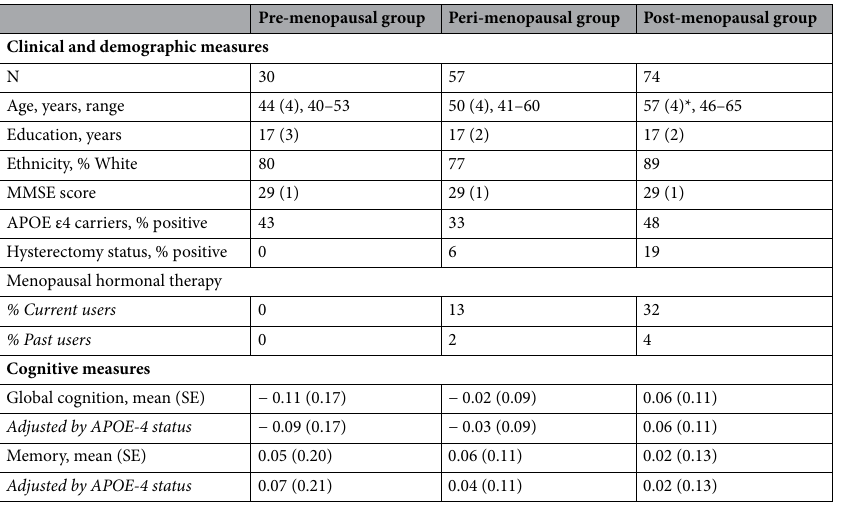
Table 1. Participants’ characteristics by menopause status. Clinical measures are means (SD), unless otherwise specified. Cognitive measures are age and education-adjusted means (SE). *Different from PRE, p <